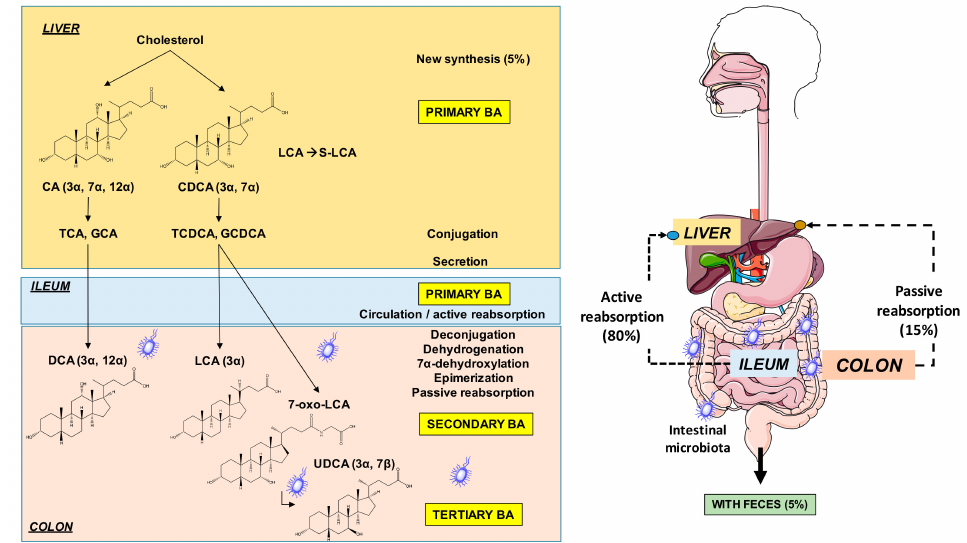
Figure 4. Sites of synthesis and metabolism of primary, secondary, and tertiary bile acids in humans. Abbreviations: CA, cholic acid; CDCA, chenodeoxycholic acid; DCA, deoxycholic acid; LCA, lithocholic acid; UDCA, ursodeoxycholic